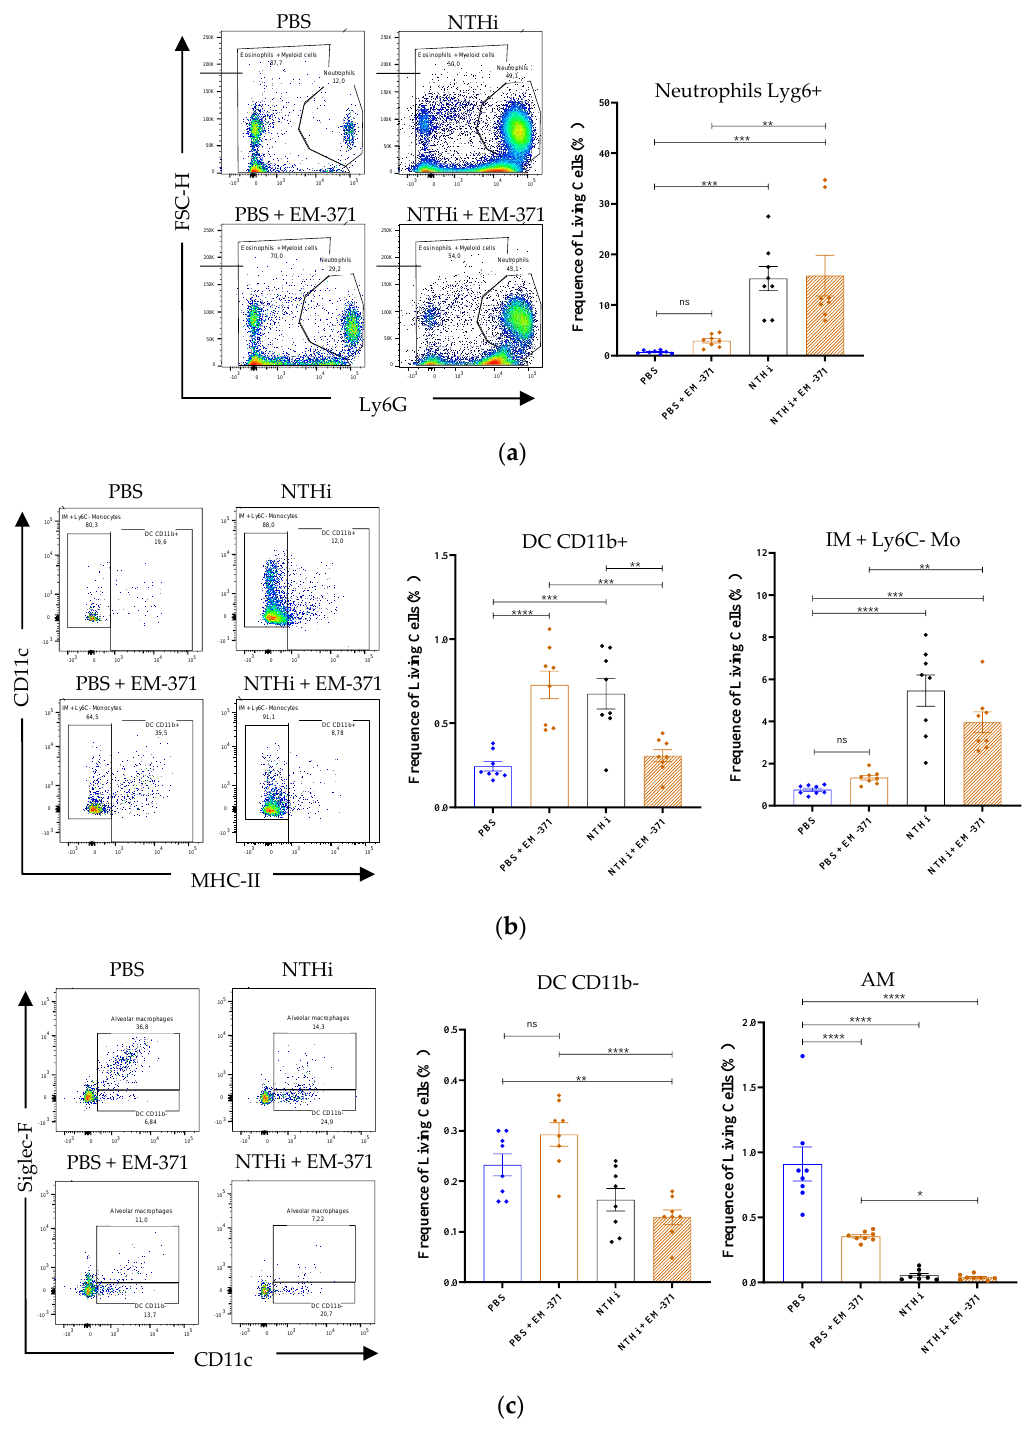
Figure 4. NTHi induced a prominent airway neutrophilia response. The frequency of ( a ) neutrophils Lyg6+, ( b ) DC CD11b+ and IM + Ly6C Mo, ( c ) CD11b- and AM were determined in lung tissue 48 h post-infection. The gating ( b , c ) are issued from the CD11b- and CD11b+ gatings, respectively (see Supplementary Figure S1 for the gating strategy). Values are expressed as the mean ± s.e.m. for one experiment (8 mice/group). To determine the statistical difference, one-way ANOVA using Tukey’s multiple comparisons test was performed with GraphPad version 8. p -values: *: p < 0.03, **: p < 0.002, ***: p < 0.0002 and ****: p < 0.0001.